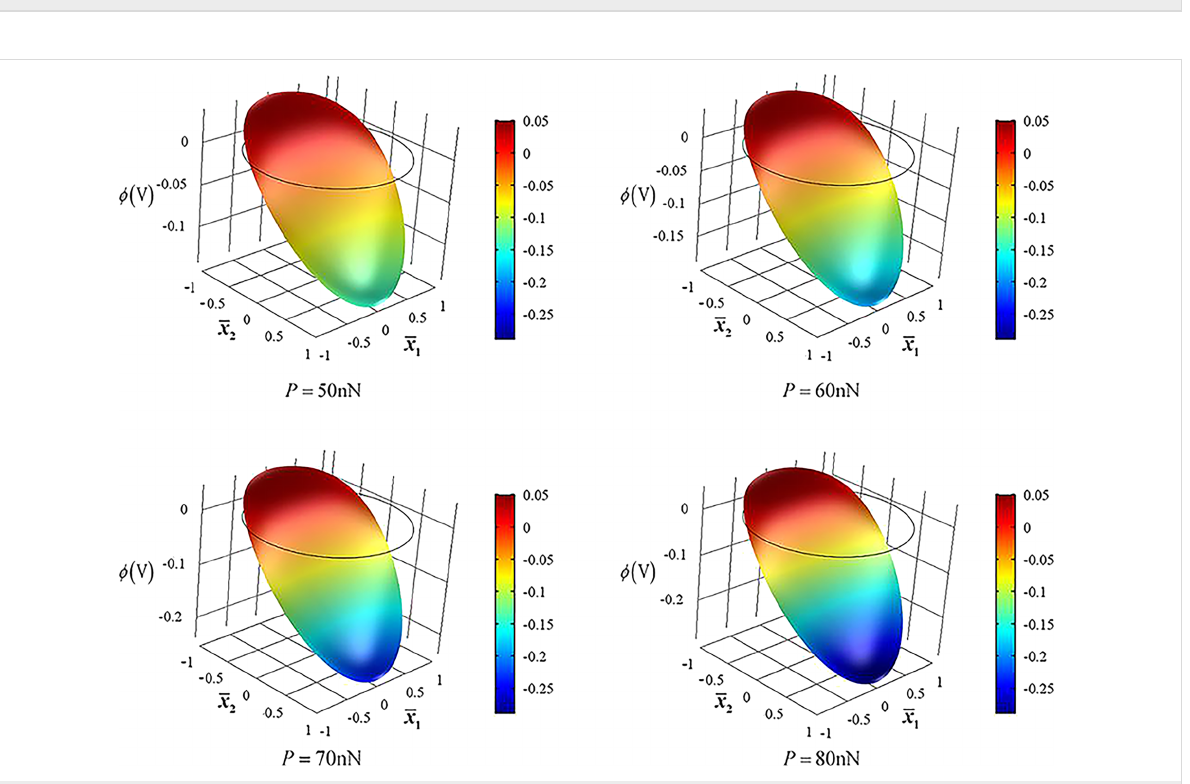
Figure 4: Distribution of electric potential in the ZNW cross section for P = 50, 60, 70 and 80